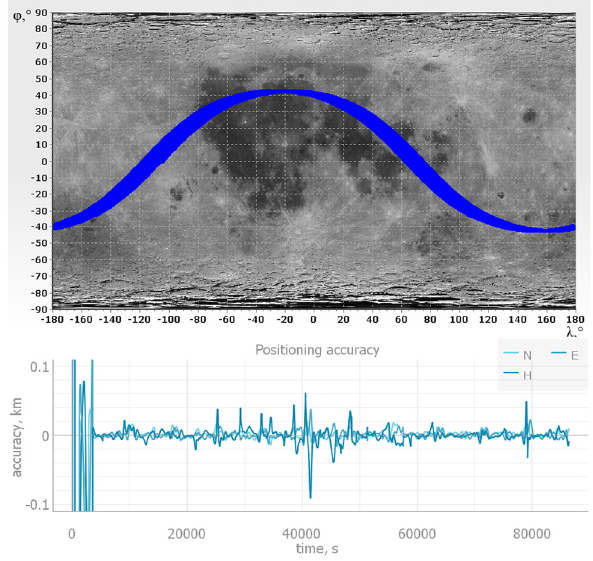
Figure 10: Orbital user positioning accuracy.